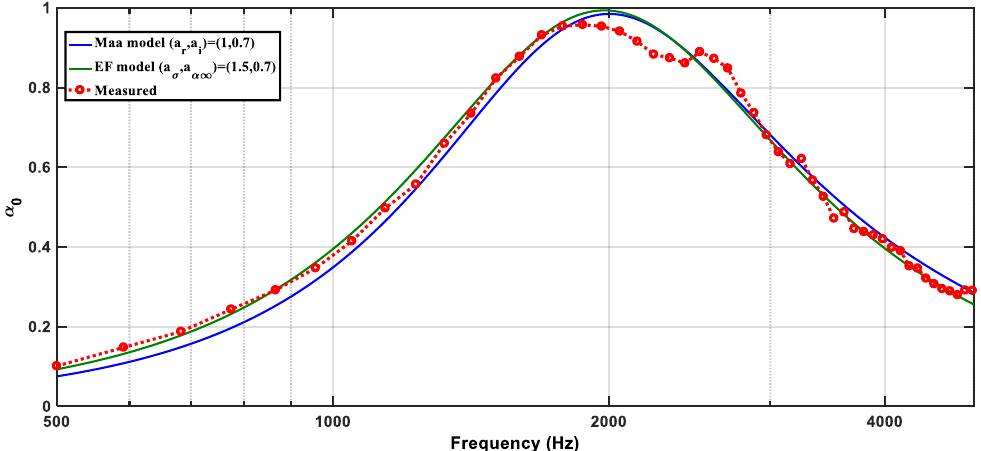
Figure 21. Measured absorption curves of the SL-MPP absorber manufactured using infiltration in comparison with those provided by the modified Maa and EF models.